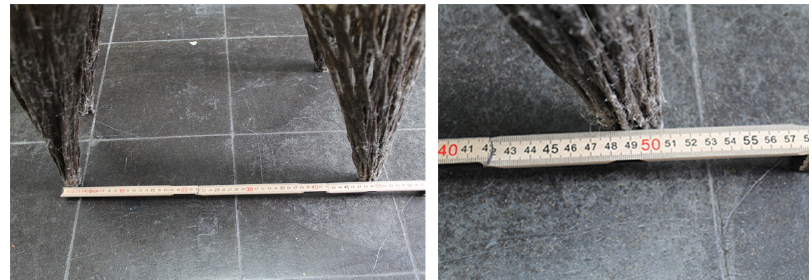
Figure 21. Sitting test measurements before sitting 50.5 cm span.